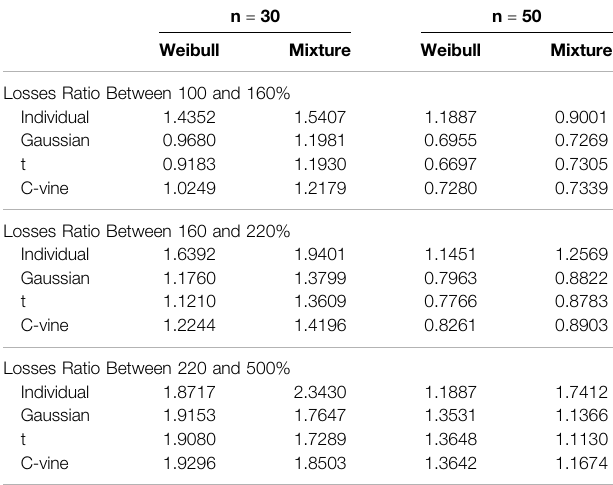
TABLE 14 | The average Mean Squared Error of aggregate losses at different layers for states in Group